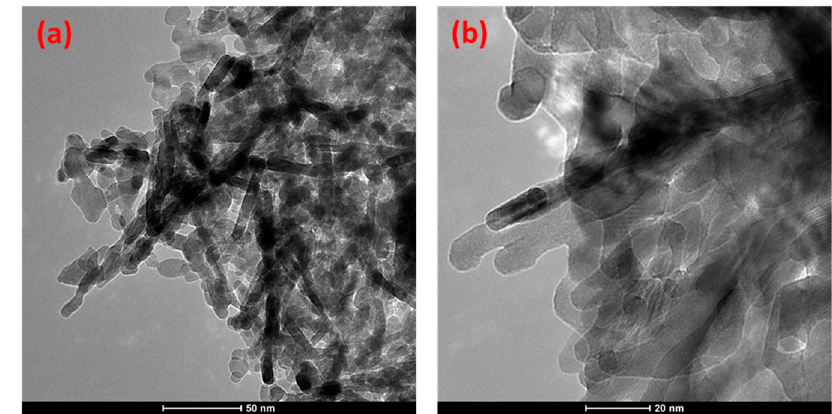
Figure 3. TEM images of CuCo 2 O 4 at various magnifications.